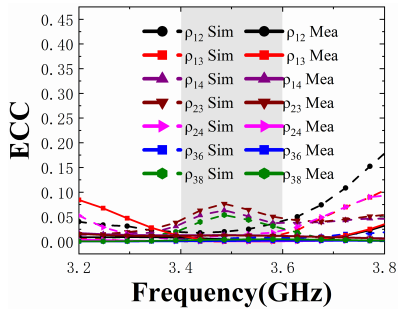
Figure 12. Simulated and measured ECC of the proposed